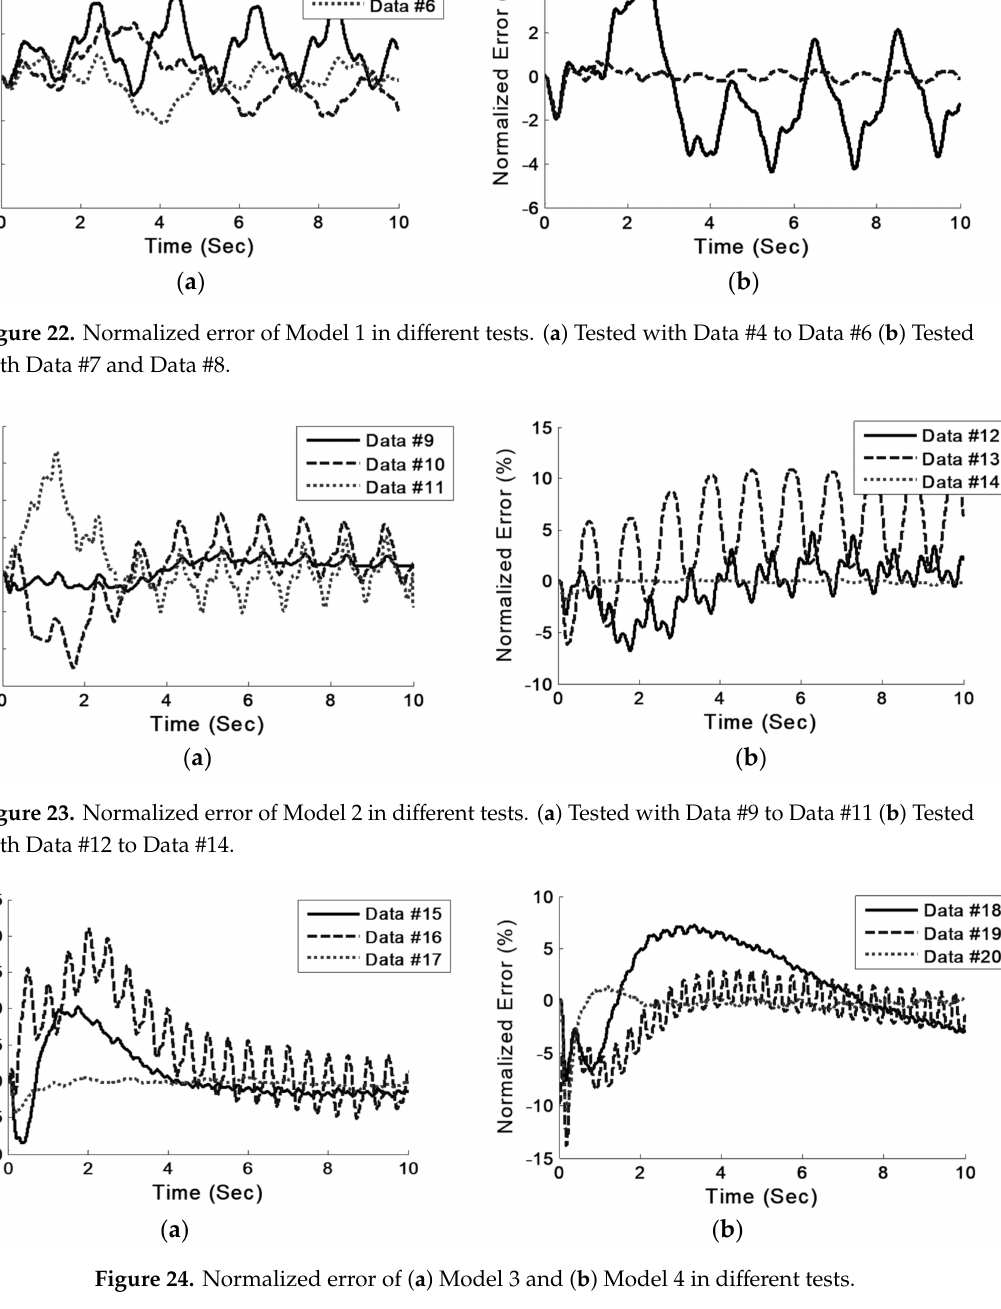
Figure 24. Normalized error of ( a ) Model 3 and ( b ) Model 4 in di ff erent